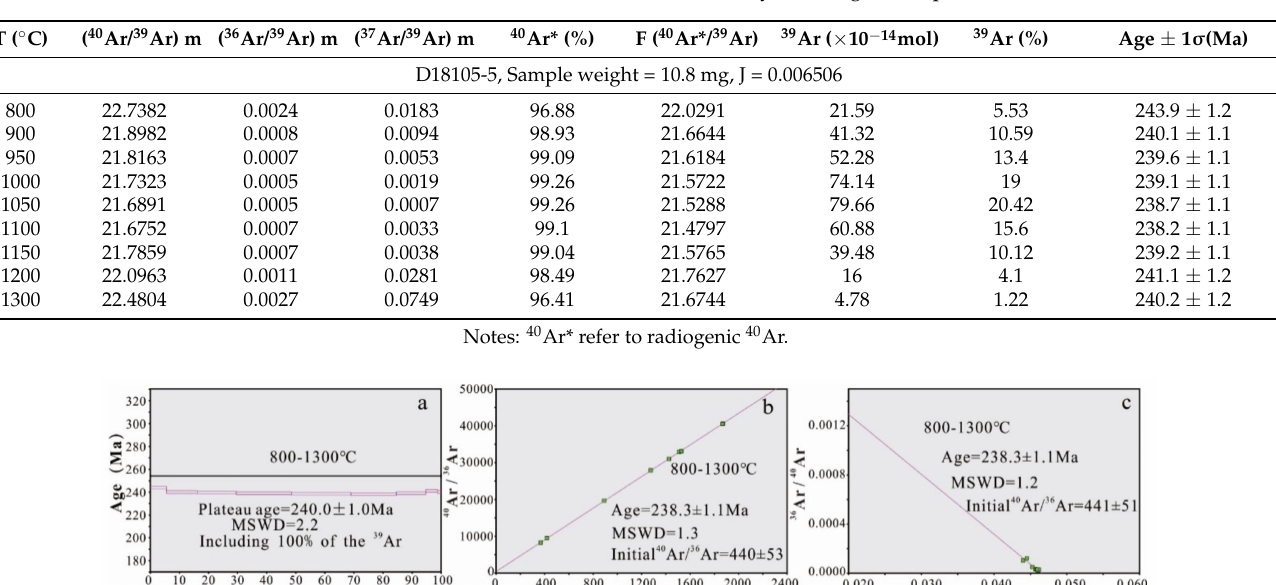
Table 5. 40 Ar- 39 Ar data for muscovite from the Juyuan tungsten deposit.